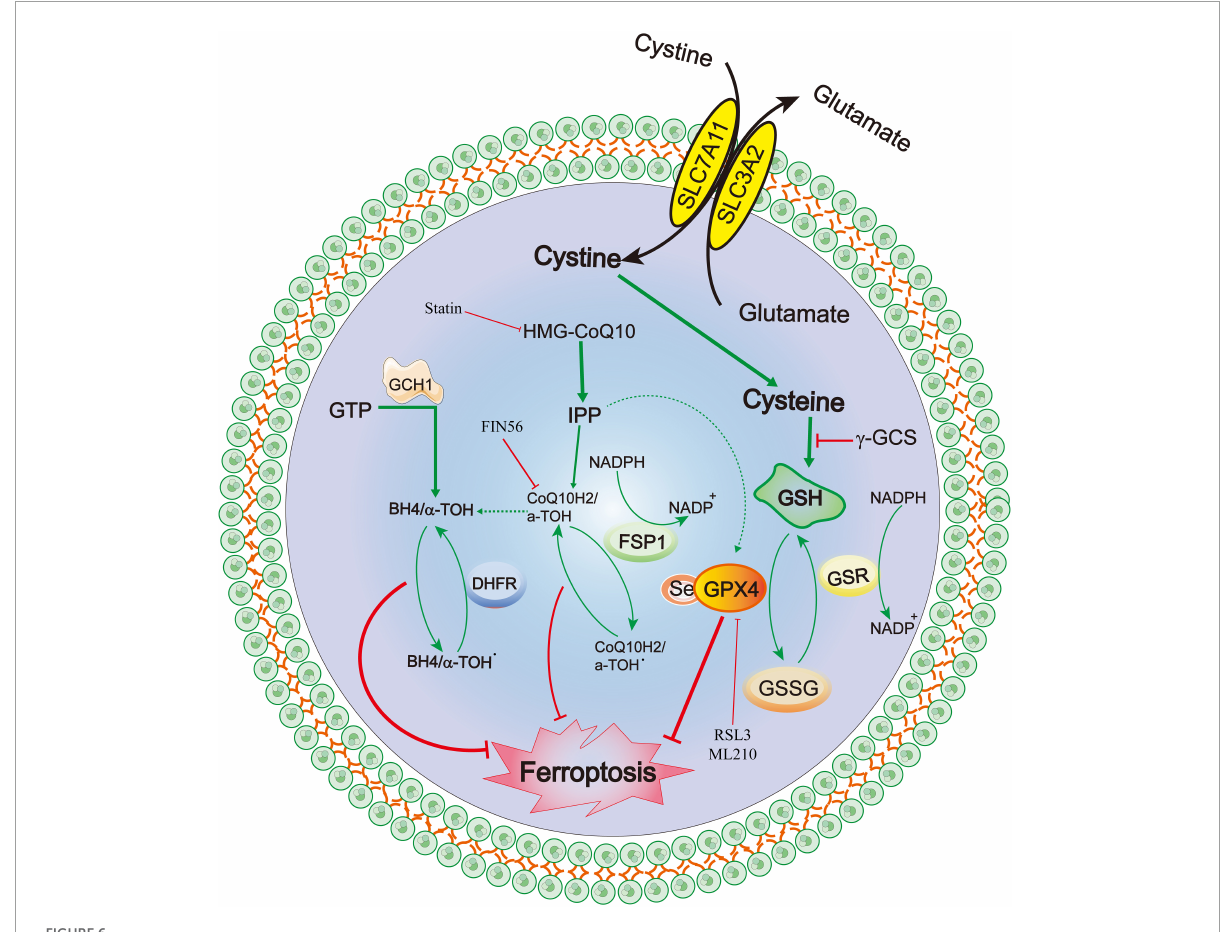
FIGURE6 Molecular mechanisms of ferroptosis from subarachnoid hemorrhage to early brain injury